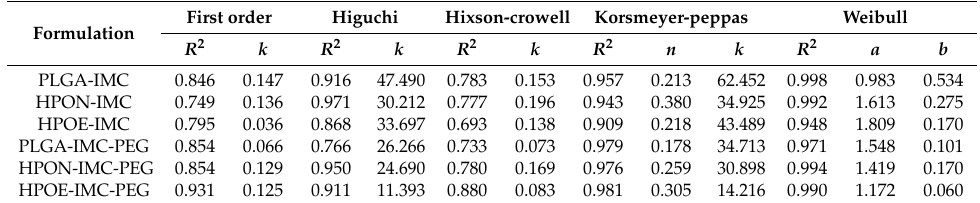
Table 5. Kinetic modeling of IMC release from all analyzed formulations Formulation